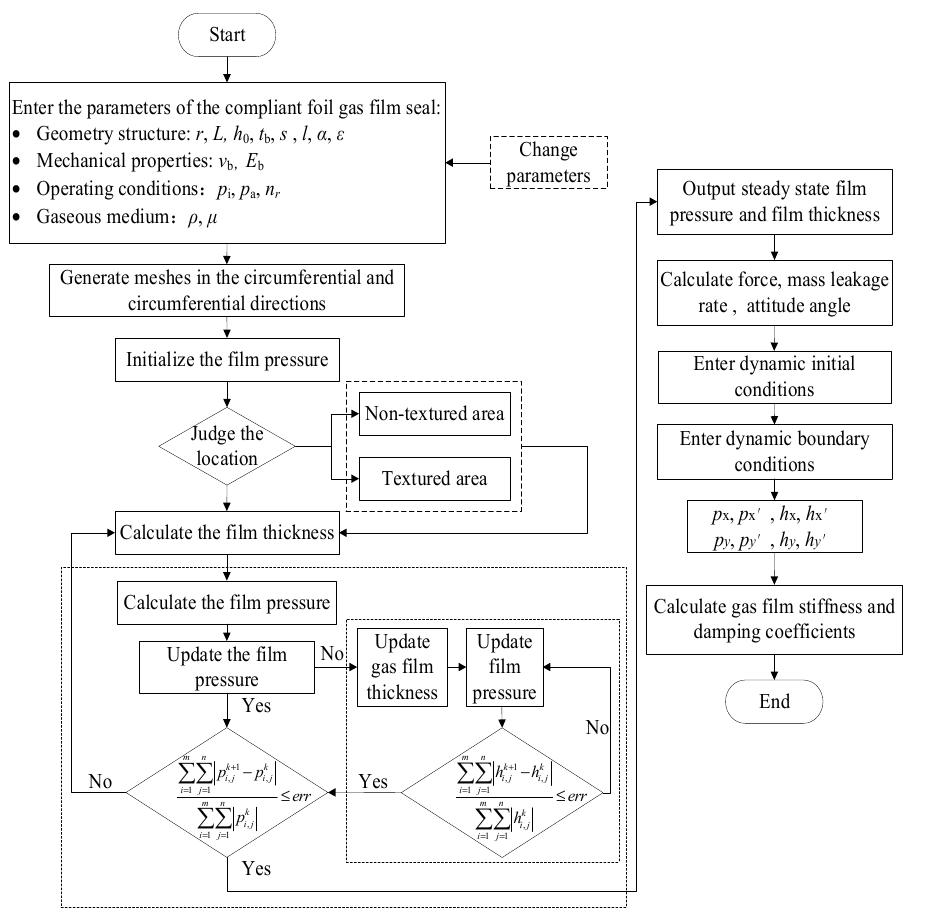
Figure 4. Calculation flow chart.